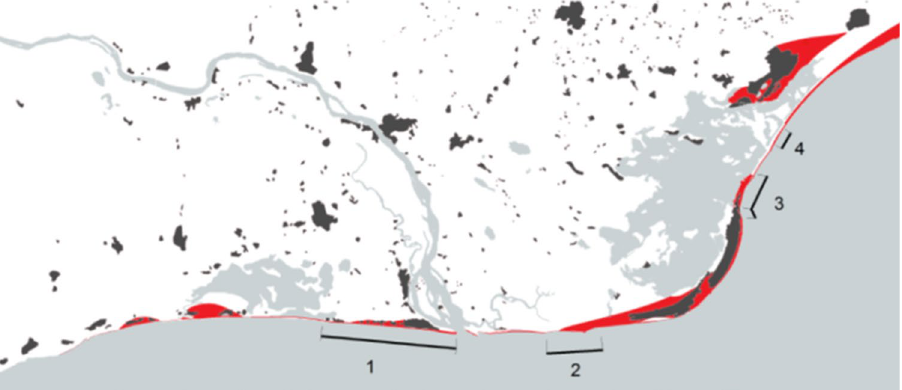
Fig. 6 Coastal defence structures along the coast